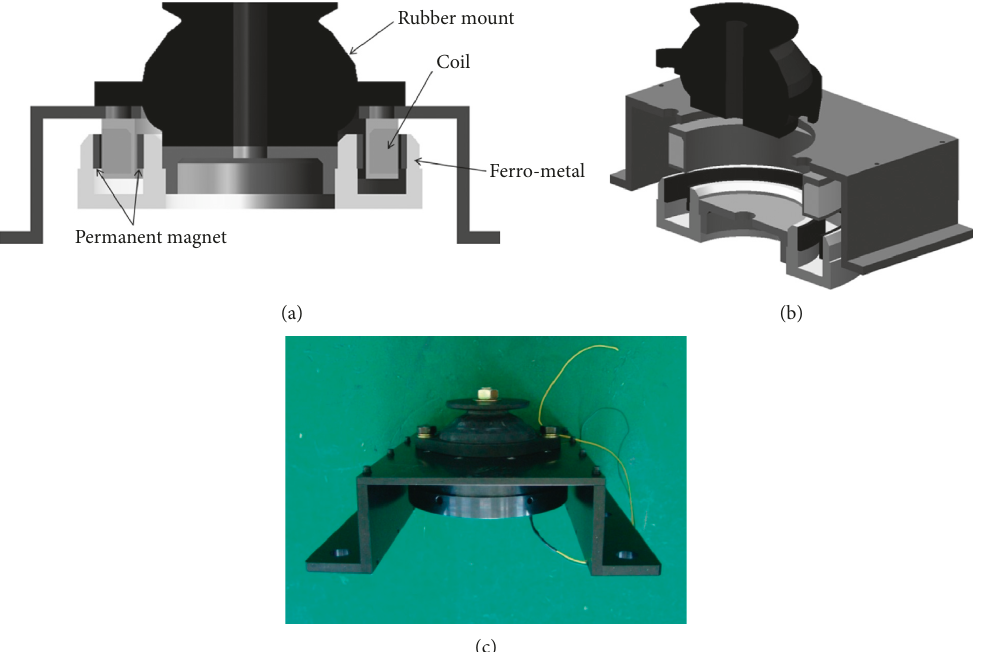
Figure 9: Assembly of modified electromagnetic actuator. (a) Sectional view. (b) Assembly schematic. (c)